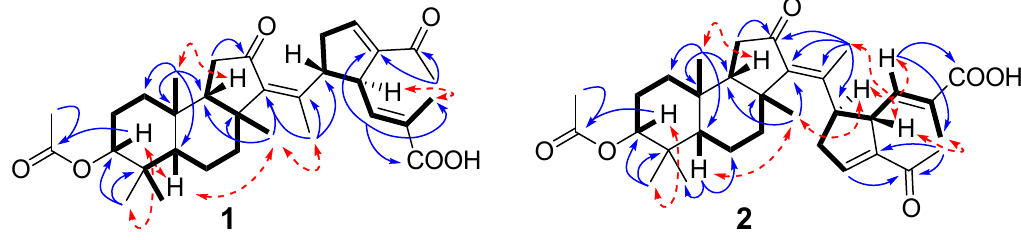
Figure 2. Selected COSY ( ), HMBC ( ) and ROESY ( ) correlations of 1 and 2 .